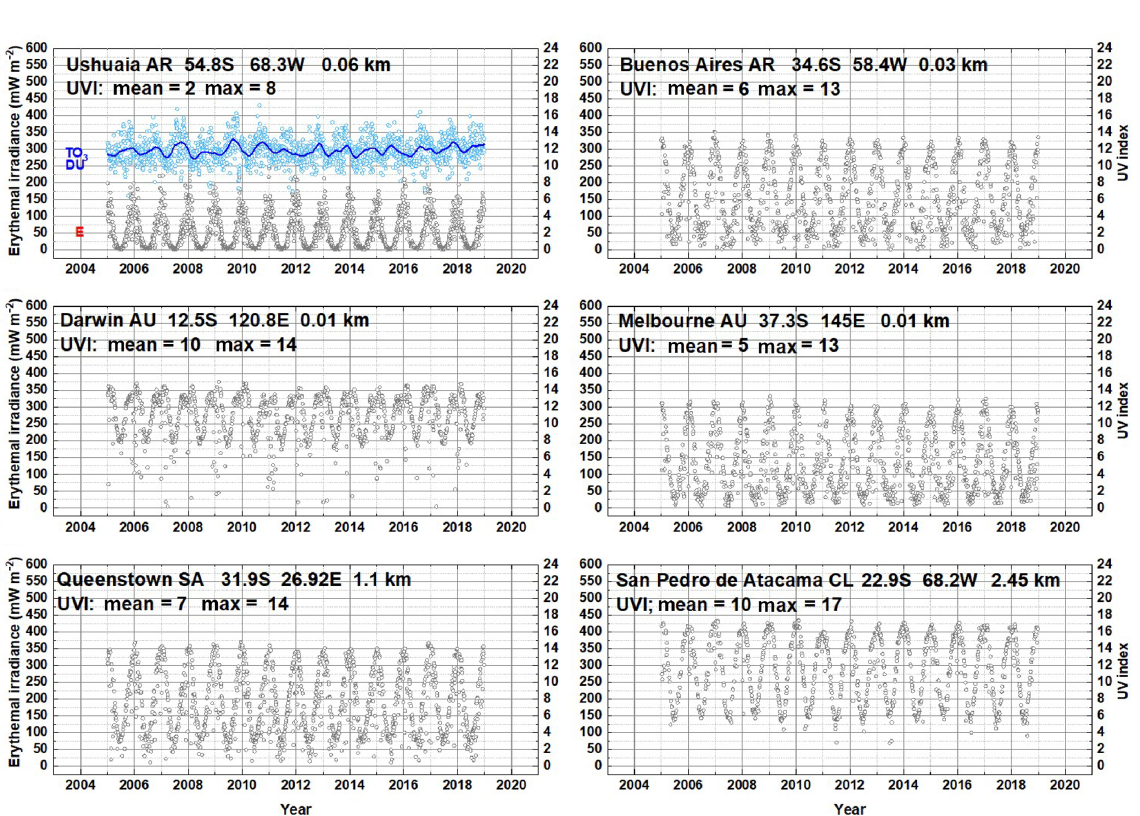
Figure 6. Six sites in the Southern Hemisphere including estimates of the trends for E(ζ,ϕ,z,t) , TCO 3 , and the atmospheric transmission C T caused by clouds and haze. The TCO 3 time series (blue) is shown for Ushuaia.